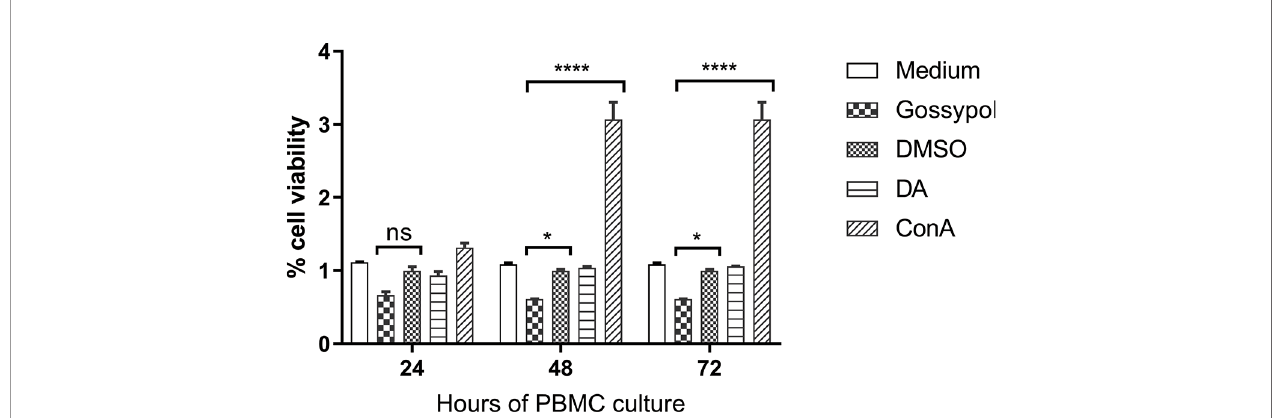
FIGURE 4 | Cell viability over a period of 72 h after incubation with the IC 98 of gossypol. PBMCs were obtained from cattle. Medium: PBMC cultured without adding compound, used as blank control; gossypol: PBMC cultured with 60 uM gossypol; DMSO: PBMC cultured with 0.06% DMSO was used as a negative control; DA: PBMC cultured with 5 m M diminazene aceturate as drug control; ConA: concanavalin A (ConA) was used as a positive control for cell proliferation. ns represents no difference; One asterisk (*) represent statistically differences and P < 0.0332; Four asterisks (****) represent statistically signi fi cant differences and P <